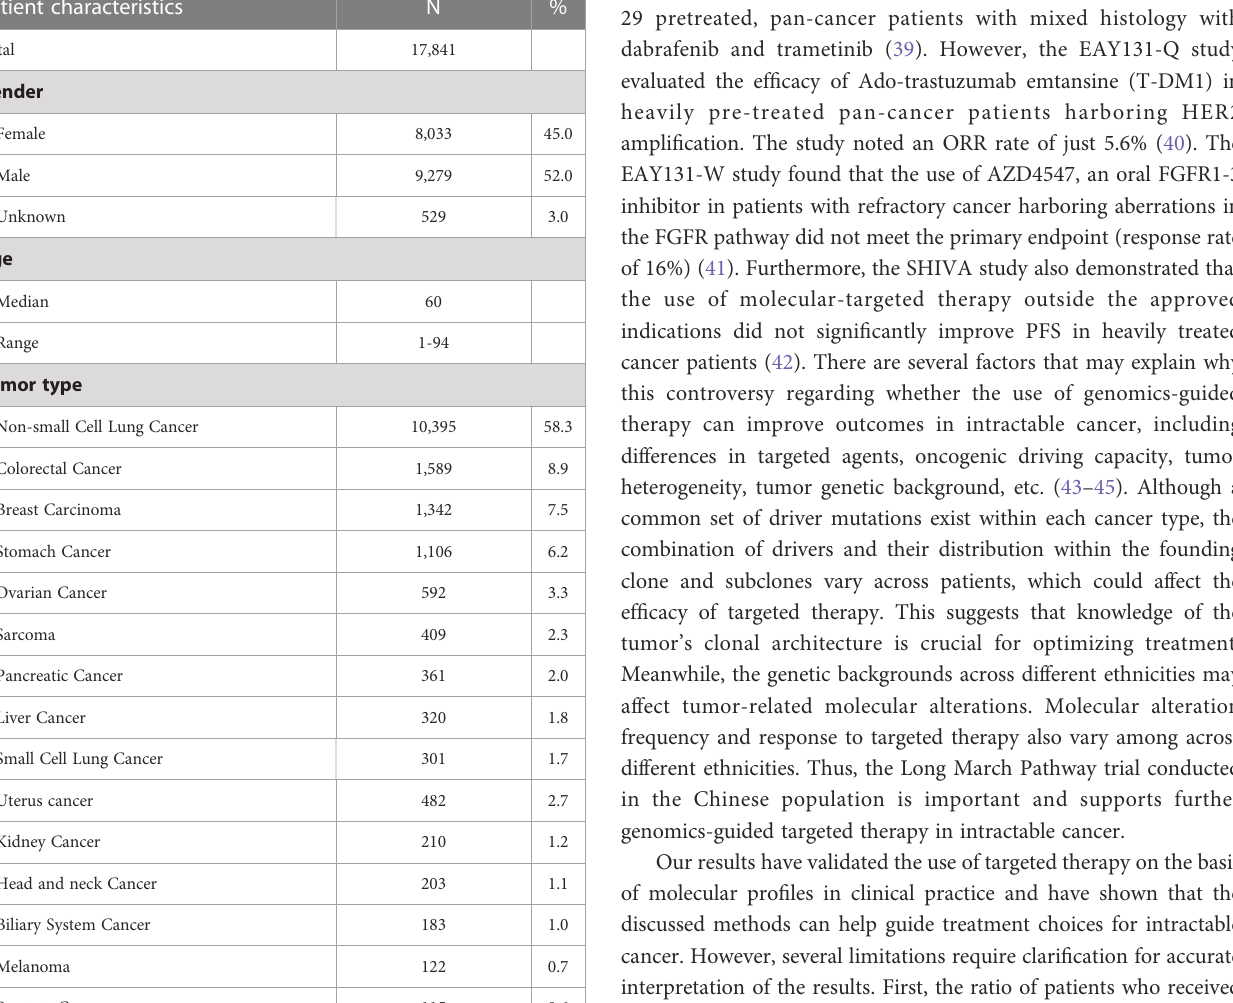
TABLE 2 Clinical characteristics of 17,841 advanced pan-cancer patients. Patient